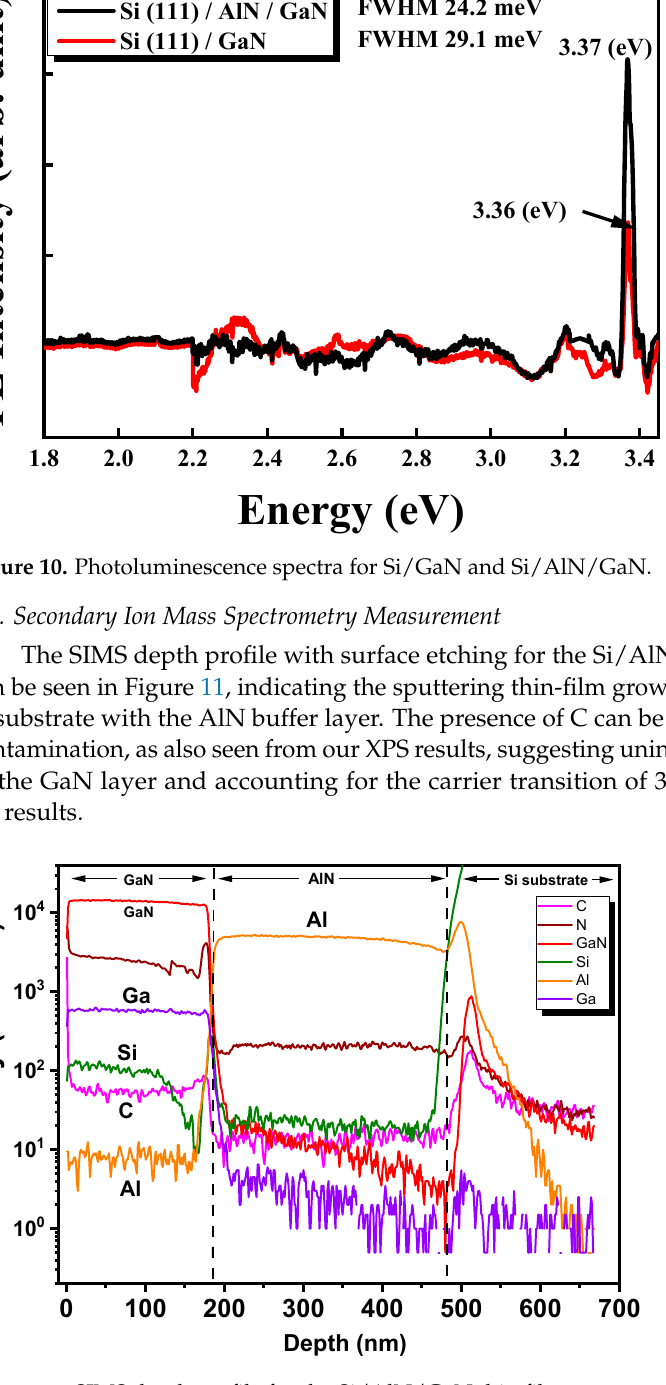
Figure 11. SIMS depth profile for the Si/AlN/GaN thin film structure.